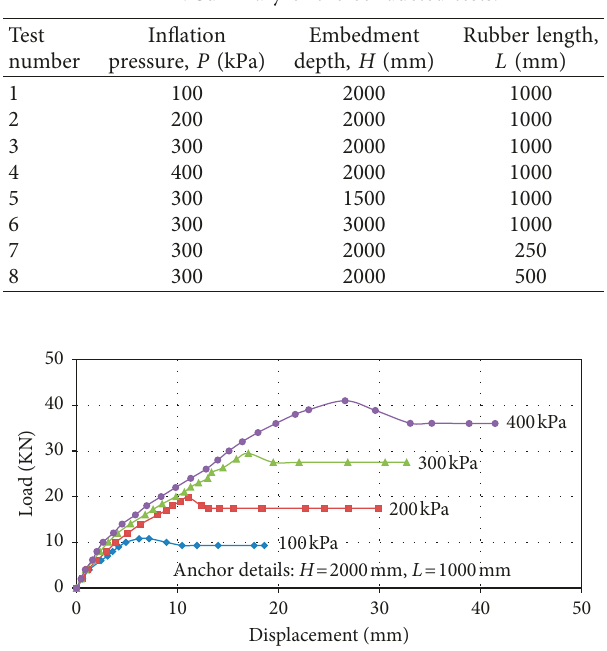
Figure 5: Anchor pullout force versus displacement for various inflation pressures.